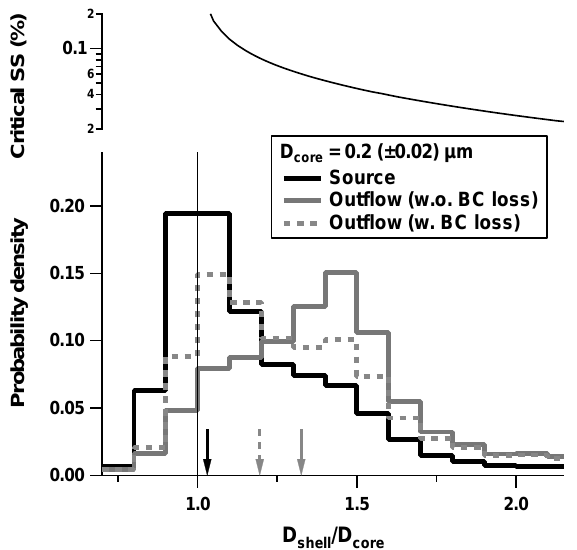
Figure 8. Probability density function of the estimated D S /D core ratios for BC-containing particles with the size 0.2 ( ± 0.02)µm at Yokosuka (black line) and in the air masses of continental outflow with (gray dashed line) and without (gray solid line) BC loss. Verti- cal arrows indicate the median values of D S /D core ratios for three different air masses. The estimated critical supersaturation of BC- containing particles detected at Fukue Island was also shown as a function of the D S /D core ratios (see the text for